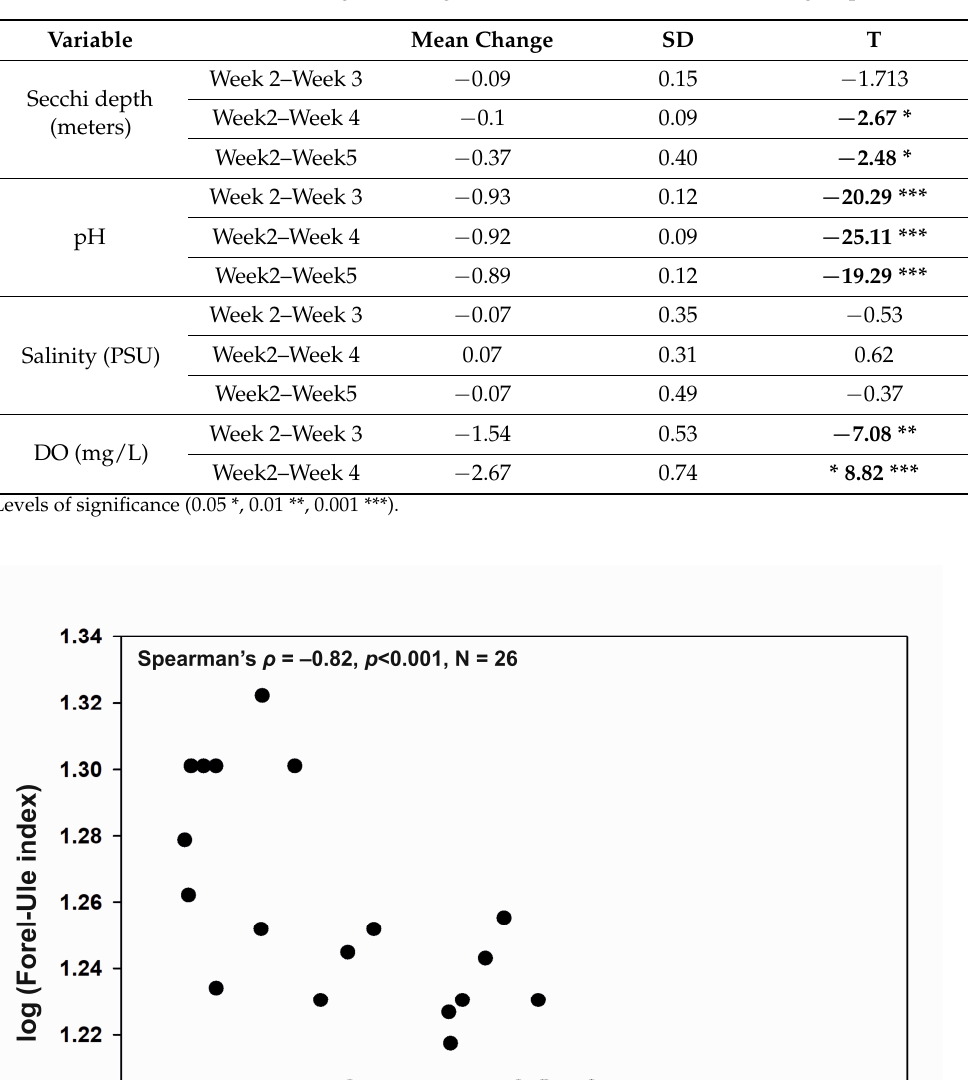
Table 1. Paired t -test table showing the comparison of water quality metrics between weeks in the post demolition period after demolition of buildings in 2020. Mean, standard deviation (SD) and significance ( t -test) are provided. Note that negative t values indicate that the measured properties increase with time. It has no bearing on the significance of the difference between groups.